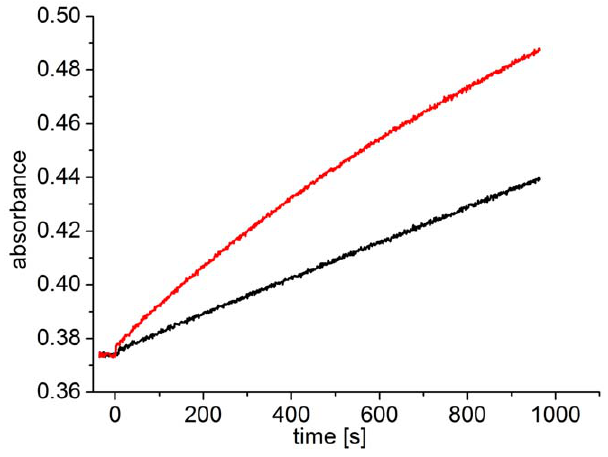
Figure 5. Dark reversion of Agp1 at 20 6 C (black) and 30 6 C (red) monitored at 700 nm. Each sample was irradiated with red light until no more absorption changes were evident. At t=0, the red light was switched off.